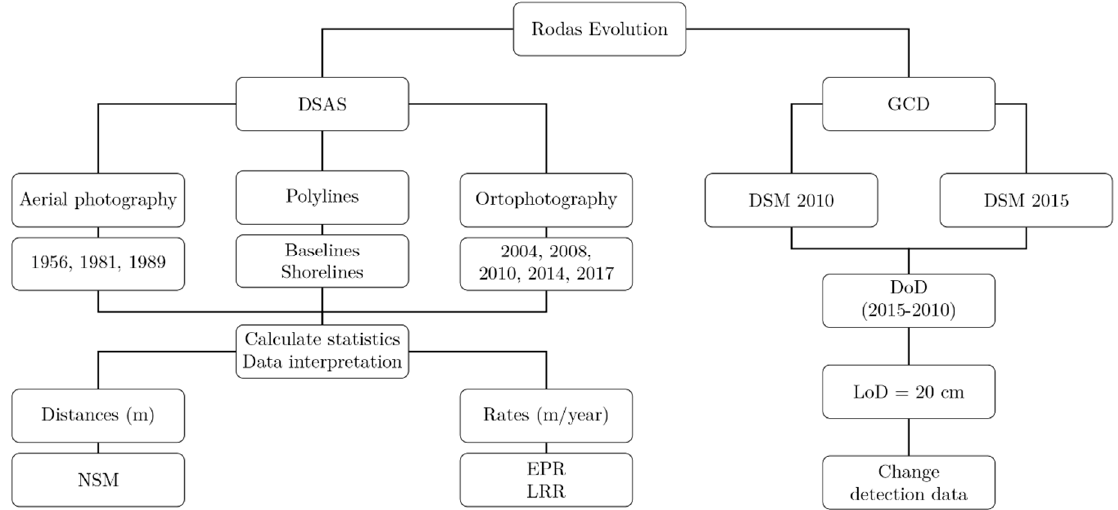
Figure 4. Flowchart with DSAS (Digital Shoreline Analysis System) and GCD (Geomorphic Change Detection) methodology and data used in this study.